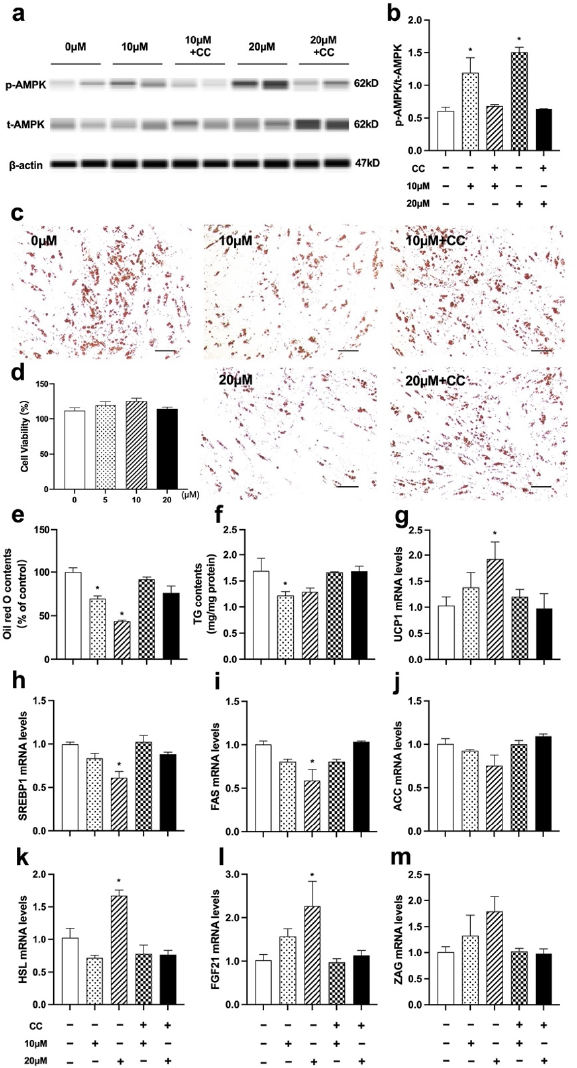
Figure 9. Nuci inhibited lipid accumulation by activating AMPK phosphorylation in fully differ- entiated human primary adipocytes. Human primary preadipocytes were cultured and induced dif- ferentiation, then fully differentiated adipocytes were treated as described in the Method 2.9. The protein levels of p-AMPK, t-AMPK, and β -actin were analyzed by Simple western ( a ), the expres- sion of p-AMPK was normalized against t-AMPK ( b ). Oil red O staining was conducted and photo- graphed at 100× magnification ( c ) and Oil red O dye was extracted and detected ( e ). Cell viability after treatment of 0~20 μ M Nuci was determined by CCK-8 ( d ). Intracellular TG contents ( f ) were determined by a commercial kit following the manufacturer’s instructions. The mRNA expressions of UCP1 ( g ), SREBP1 ( h ), FAS ( i ), ACC ( j ), HSL ( k ), FGF21 ( l ), and ZAG ( m ) were determined by RT-qPCR. Data were presented with mean ± SE from three independent experiments, * p < 0.05 vs. the control group (0 μ M).